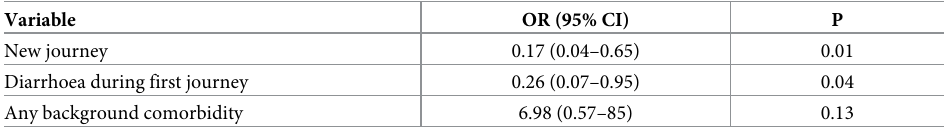
Table 3. Risk factors for prolonged carrier state. Final multivariate logistic regression model after elimination of fac- tors with p > 0.15 in univariate